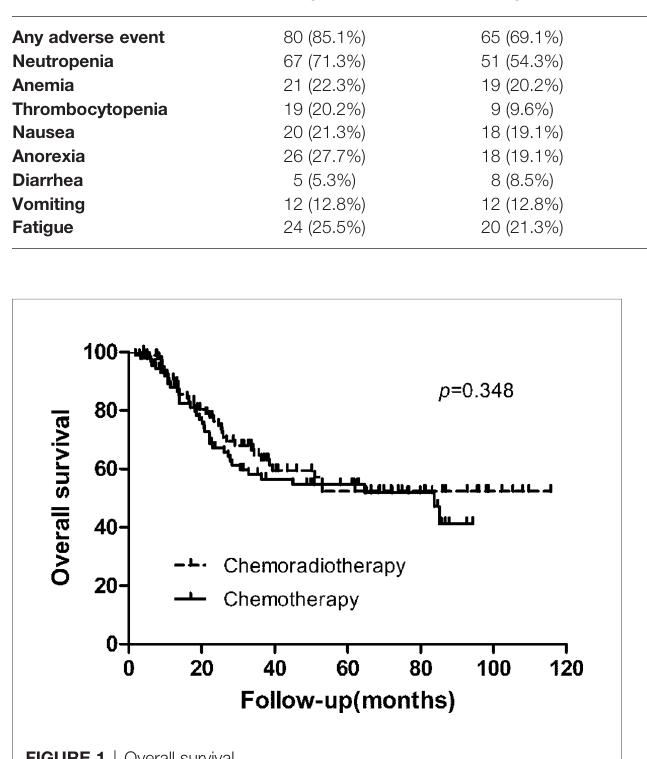
FIGURE 1 | Overall survival.